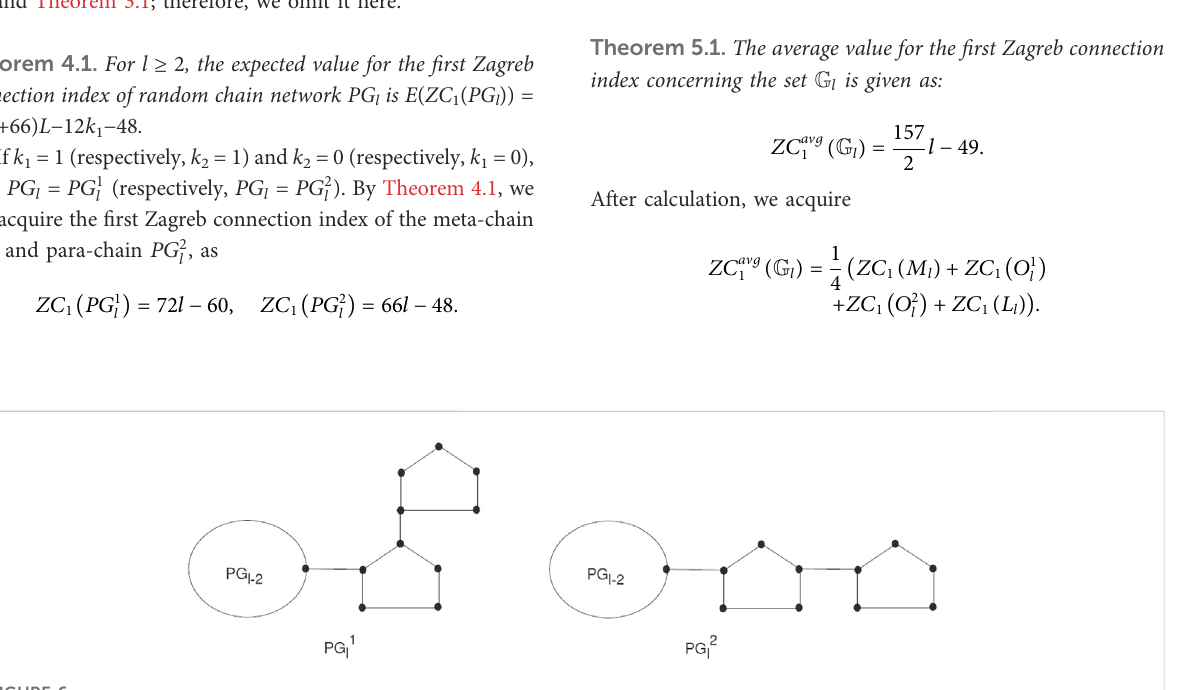
FIGURE 6 The two types of local arrangements of pentagons PG 1 l and PG 2 l